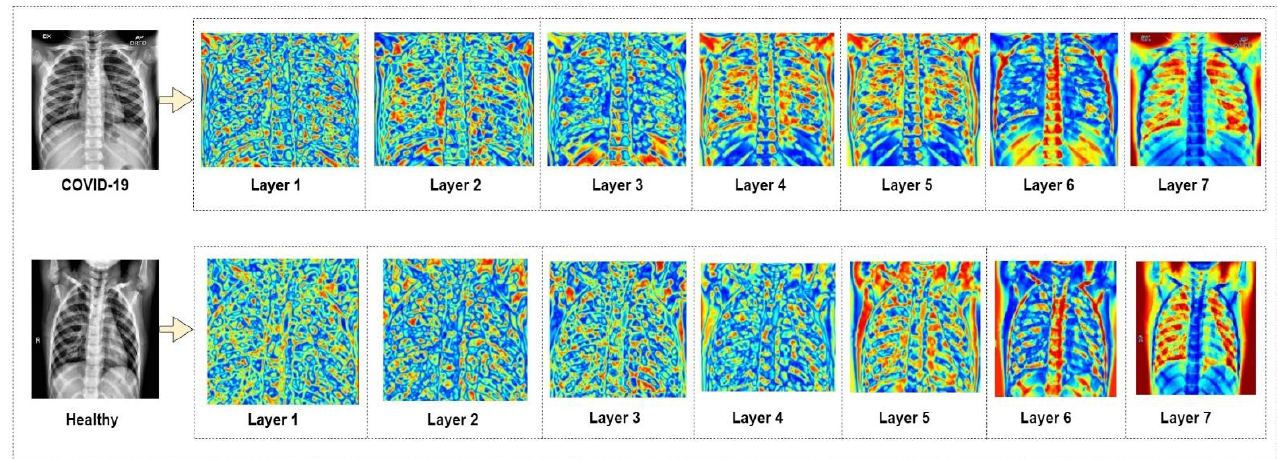
Figure 7. Heat map of modified MobileNetV2 classification.